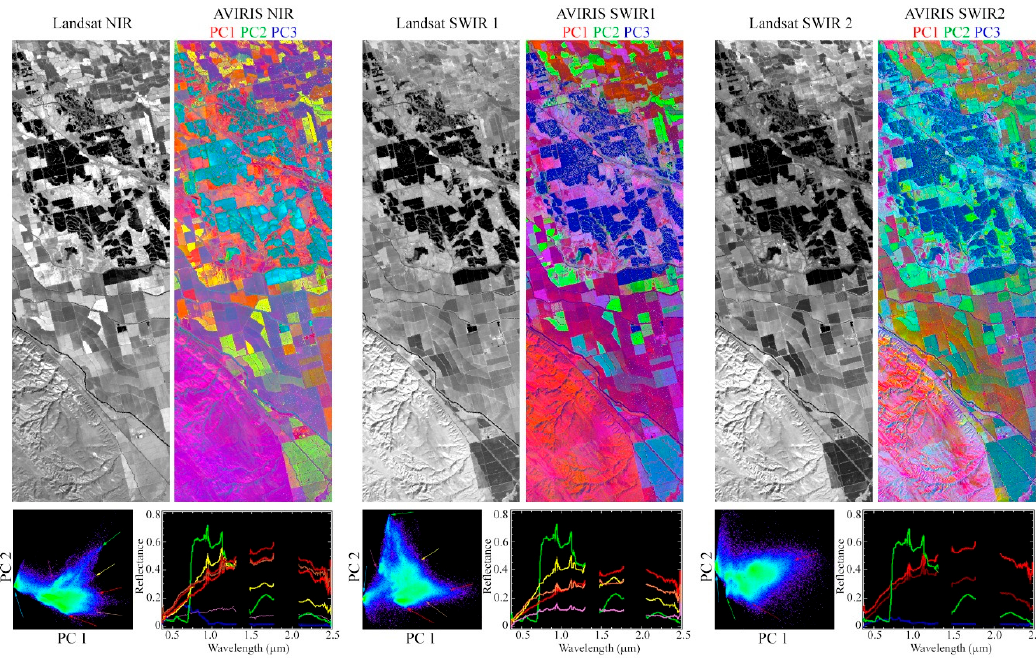
Figure 9. Intraband and interband spectral dimensionality of AVIRIS in comparison to individual infrared bands of Landsat OLI. OLI is one dimensional in each of the NIR, SWIRl, and SWIR2 spectral regimes because the sensor only collects in one band for each. In contrast, AVIRIS collects in over 40 channels for each of the three spectral regimes. The spectral dimensionality of the hyperspectral imagery is apparent in the color images of the three lowest-order Principal Components for the channels within each regime, as well as in the structure for the corresponding spectral feature spaces. Dark and vegetation EMs are similar for each feature space but substrate EMs differ because of distinct absorptions. EM locations are indicated on each feature space by colored arrows.